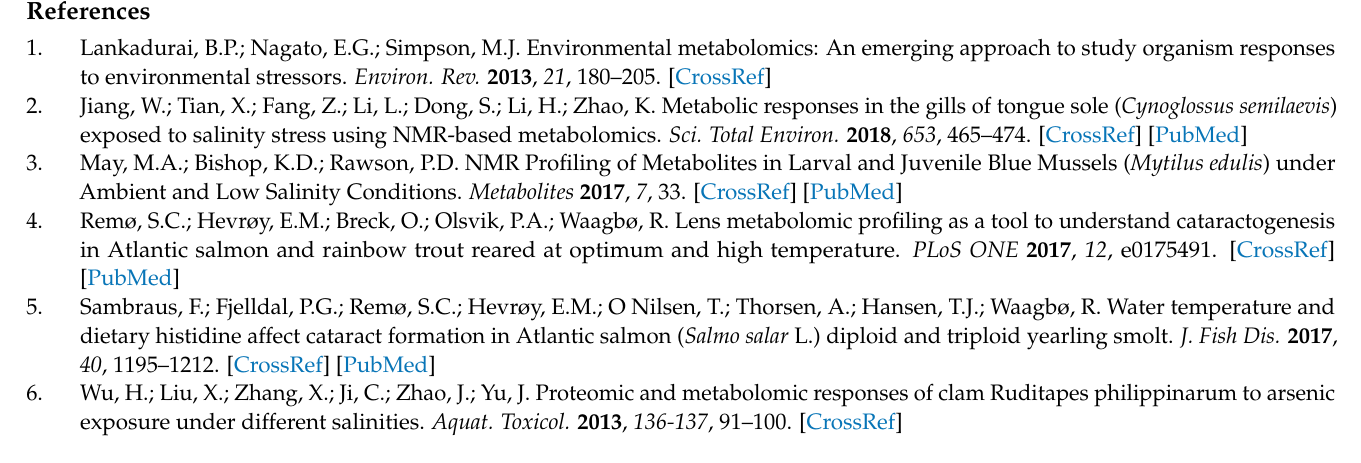
Supplementary Figure S1: Map showing locations of the fish sample collection. Supplementary Figure S2: Correlations between LDO level and abundances of metabolites in the lens of P. fluviatilis